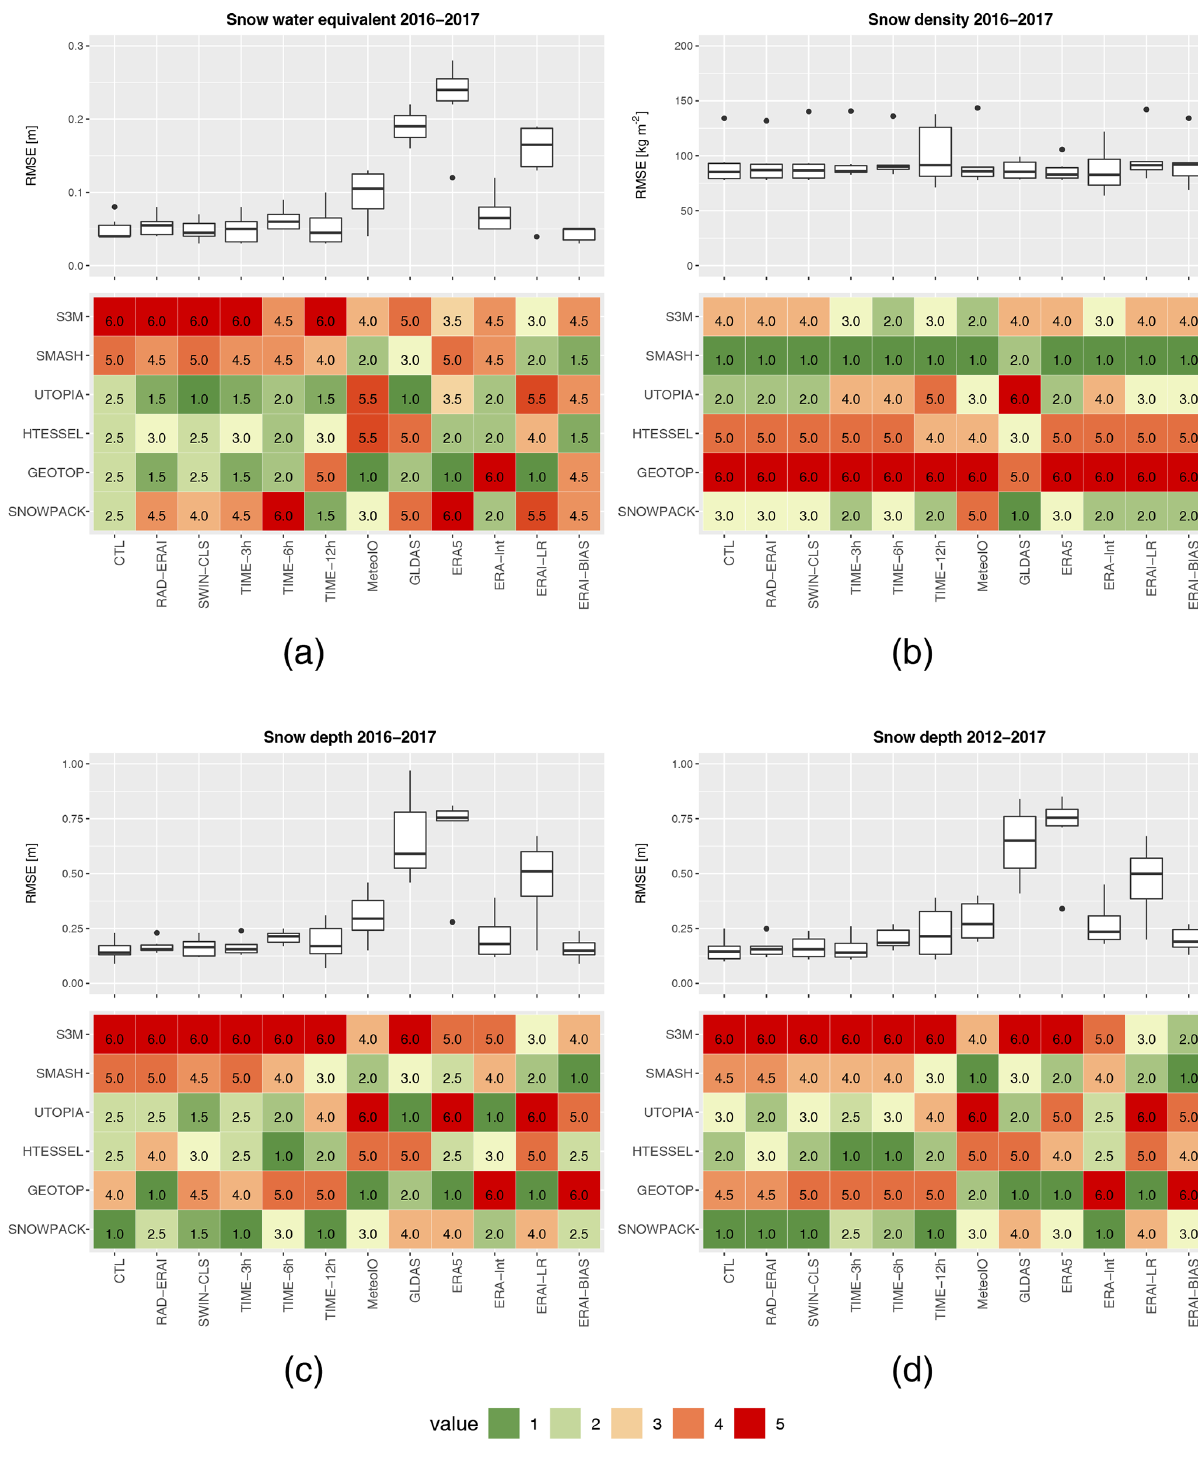
Figure 6. Root mean square error associated with (a) snow water equivalent, (b) snow density, and (c) snow depth simulations for each experiment and each model over the period 2016–2017. (d) shows the same statistics as (c) but on the whole period 2012–2017. For each plot ( a, b, c, d ) upper panels represent the boxplot statistics and bottom panels represent the model rank (1: best model; 5: worst